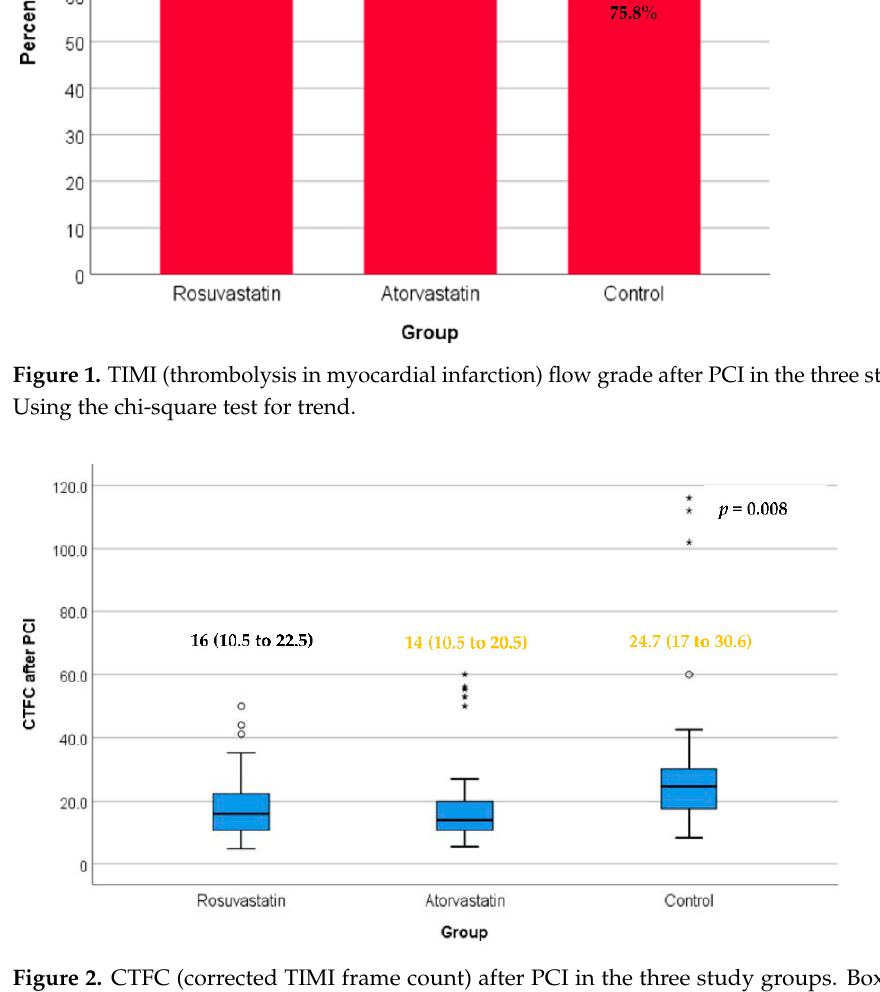
Figure 2. CTFC (corrected TIMI frame count) after PCI in the three study groups. Box represents the interquartile range. Line inside the box represents the median. Error bars represent minimum and maximum values excluding outliers (rounded markers) and extreme values (asterisks). There was a statistically significant difference between the atorvastatin and control groups. Differences between the rosuvastatin and atorvastatin groups and between the rosuvastatin and control groups were not statistically significant. p = 0.003 for atorvastatin versus control (Conover test); p = 0.020 for rosuvastatin versus control; p = 0.788 rosuvastatin versus atorvastatin (Conover test).